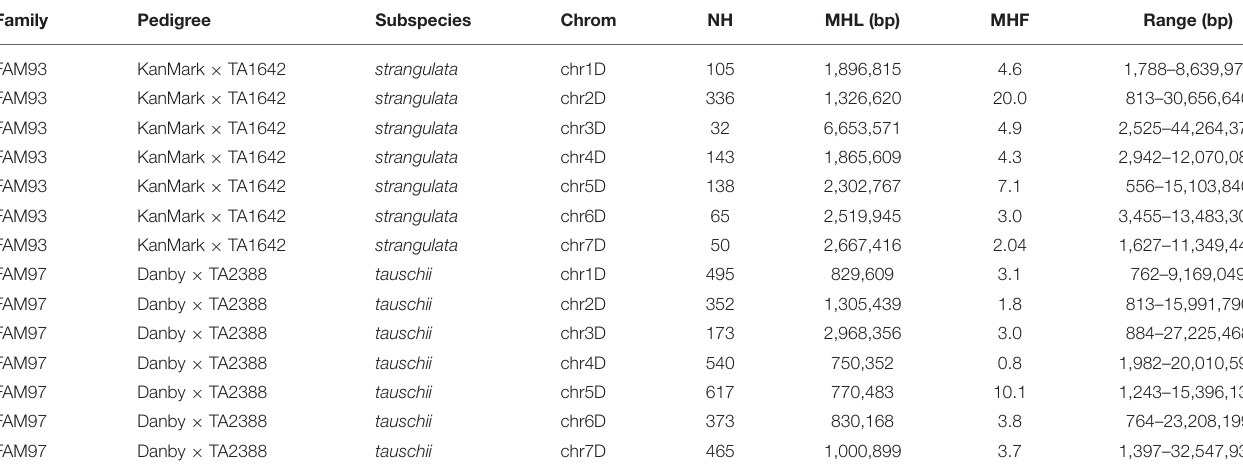
TABLE 3 | Variation of introgressed haplotypes between Aegilops tauschii ssp. strangulata (FAM93) and A. tauschii ssp. tauschii (FAM97) families. Family